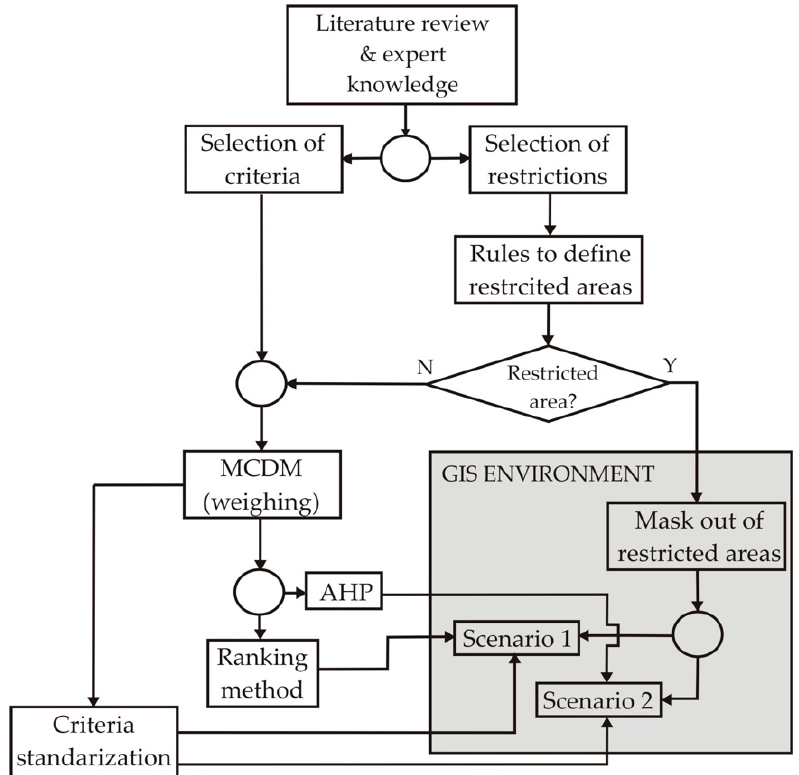
Figure 2. Flowchart summarizing the methodology for the evaluation of site-suitability for the development of solar farms. MCDM: Multi-criteria decision-making, AHP: Analytical Hierarchy Process, GIS: Geographic Information Systems.